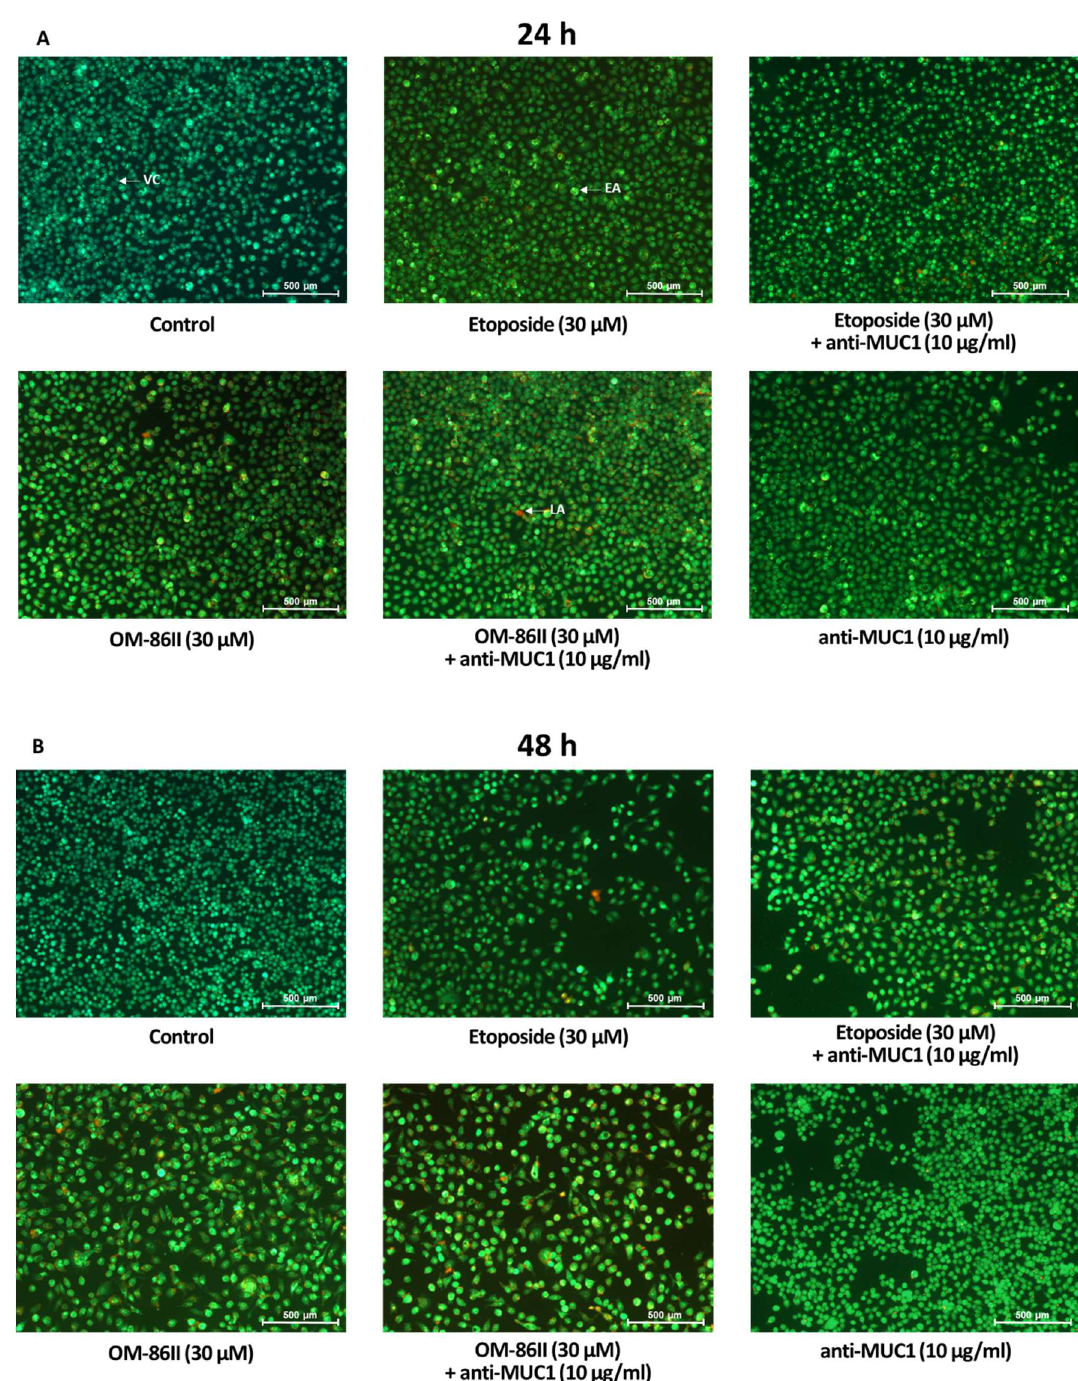
Figure 3. The influence of anti-MUC1 (10 µg/mL), OM-86II (30 µM), OM-86II + anti-MUC1 (30 µM + 10 µg/mL), etoposide (30 µM) and etoposide + anti-MUC1 (30 µM + 10 µg/mL) on induction of apoptosis in human AGS cells after 24 h ( A ) and 48 h ( B ) of incubation. The evaluation was performed by a fluorescent microscopy after acridine orange and ethidium bromide staining.